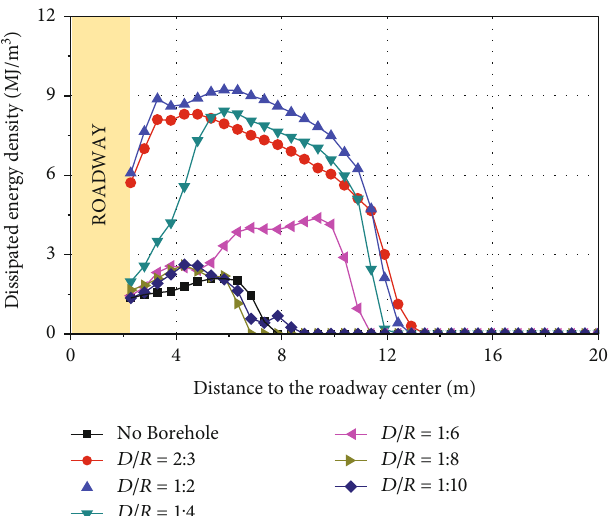
Figure 7: DED distributing curves between the neighboring boreholes in X direction under di ff erent D / R ratios. The data were extracted from the B-B ′ section in Figure 5(a).